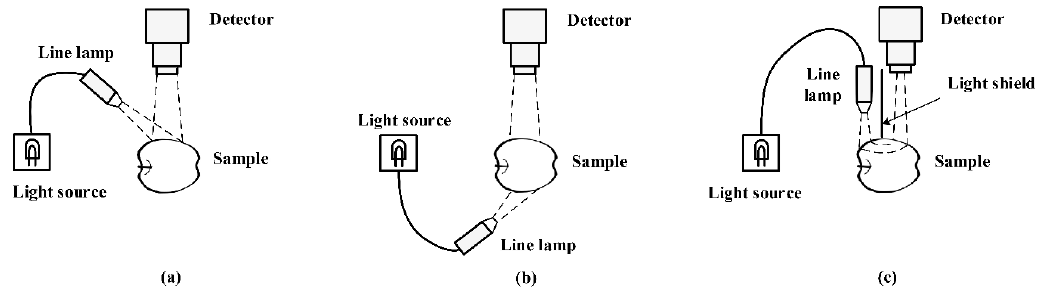
Figure 3. Three sensing modes commonly used for hyperspectral image acquisition: ( a ) reflectance, ( b ) transmittance and ( c ) interactance.